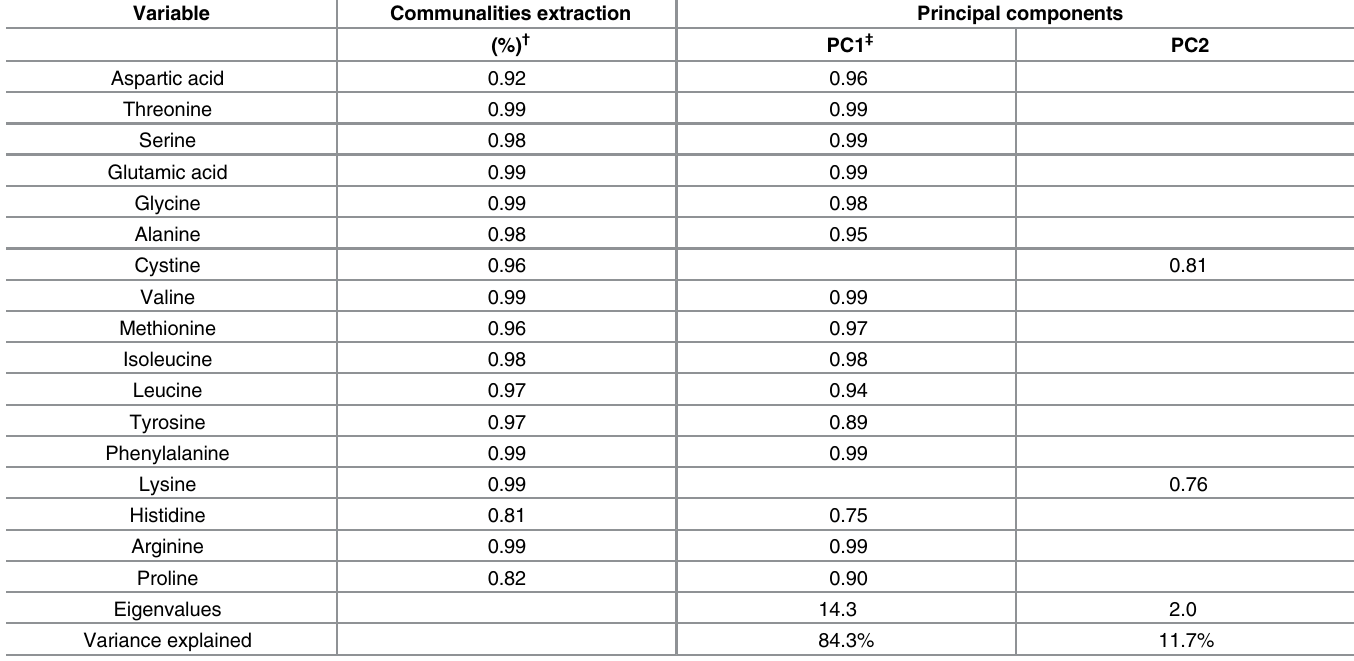
Table 2. Loadings of the 17 different hydrolyzable amino acid variables on two significant principal components for the thirteen soils.